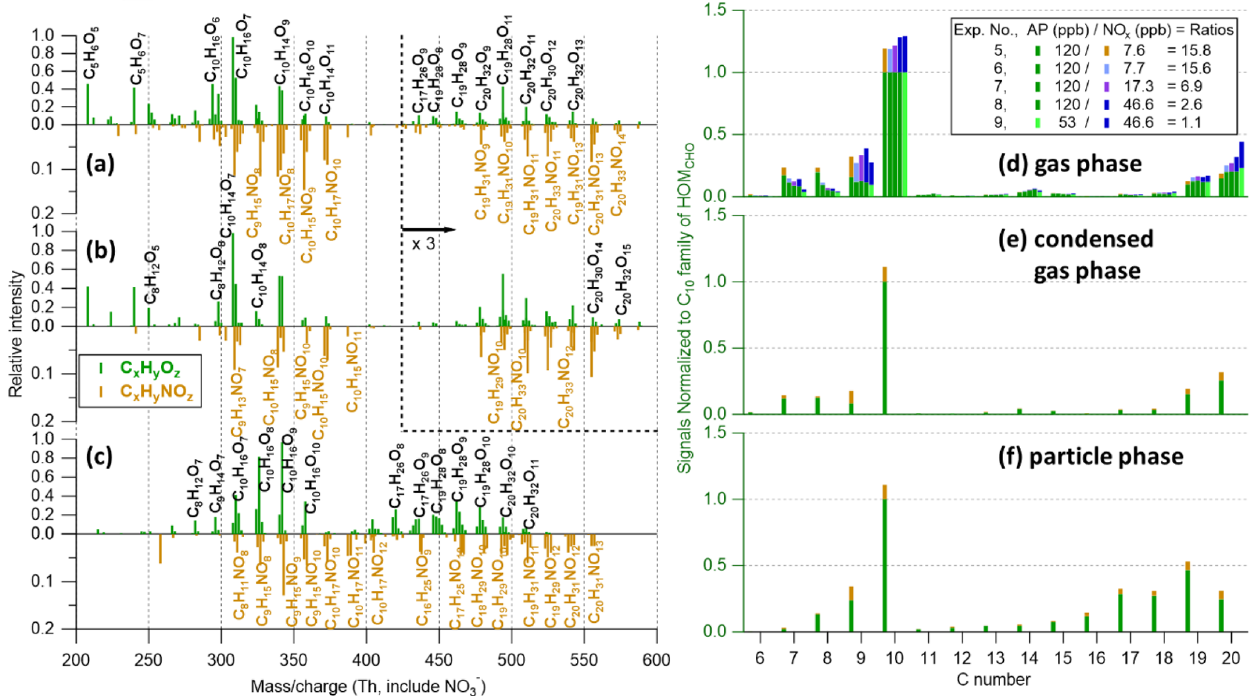
Figure 7. (a–c) Mass spectra of (a) gas-phase (without seed), (b) condensed-gas-phase (from the difference between spectra without and with seed particles), and (c) particle-phase (at 230 ◦ C) measurements from experiment no. 5 (input flow condition of 120ppb α -pinene, 33ppb O 3 , and 7.6ppb NO 2 with UV lights off). Note that the y axes of HOM CHO (green spectrum, upward) and HOM ON (brown spectrum, downward) are on different scales. Gas-phase and condensed-gas-phase mass spectra (30min average) are normalized to (C 10 H 14 O 7 )NO 3 at m/z 308, with peaks larger than 420Th being multiplied by a factor of 3. Particle-phase mass spectra (60min average) are normalized to (C 10 H 16 O 9 )NO 3 at m/z 342. (d–f) The distribution of HOM products (varying initial α -pinene to NO x ratios from 15.8 to 1.1), grouped by carbon numbers, in the (d) gas phase, (e) condensed gas phase, and (f) particle phase. Signals are normalized to the HOM CHO C 10 family. The UV lights were off during the entire experiment, making experiment no. 5 (HOM ON as brown bars) the only one with particle-phase HOM measurements from α -pinene and NO 3